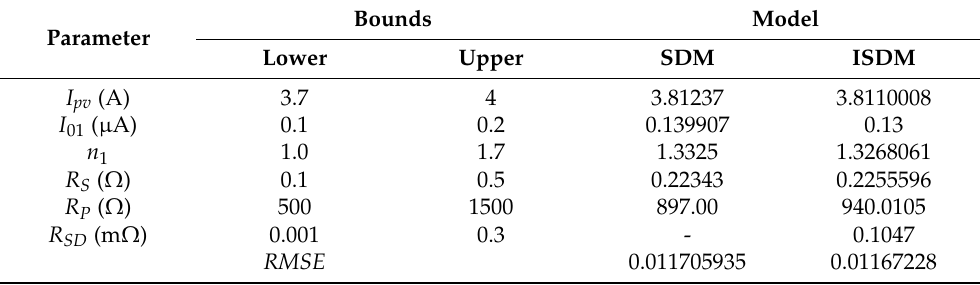
Table 4. Lower and upper bounds of the parameters and the results obtained for the Solarex MSX 60 module for both SDM and ISDM.